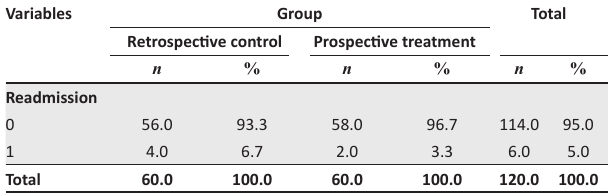
TABLE 5: Comparison of patient safety 30-day readmission rate between the two groups. Variables Group Total